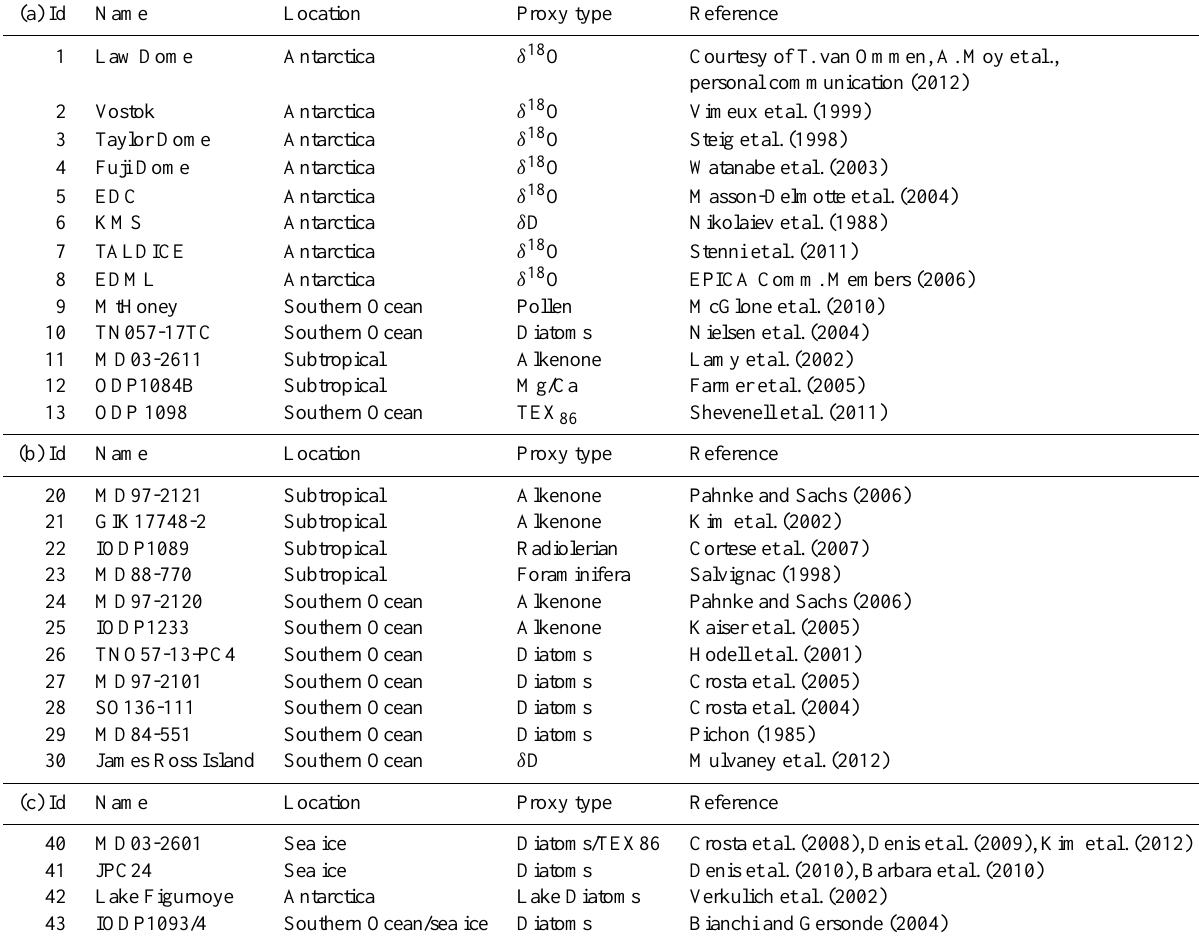
Table 1. (a) Description of all the proxy records used in the data assimilation experiments. (b) Description of all the proxy records used for model validation. (c) Description of all qualitative proxy types used in the text. The classification of proxy records from the subtropical area or from the Southern Ocean (north of 66 ◦ S and south of subtropical front) depends on the type of climate dynamics suggested in the corresponding reference. By default, diatoms are marine